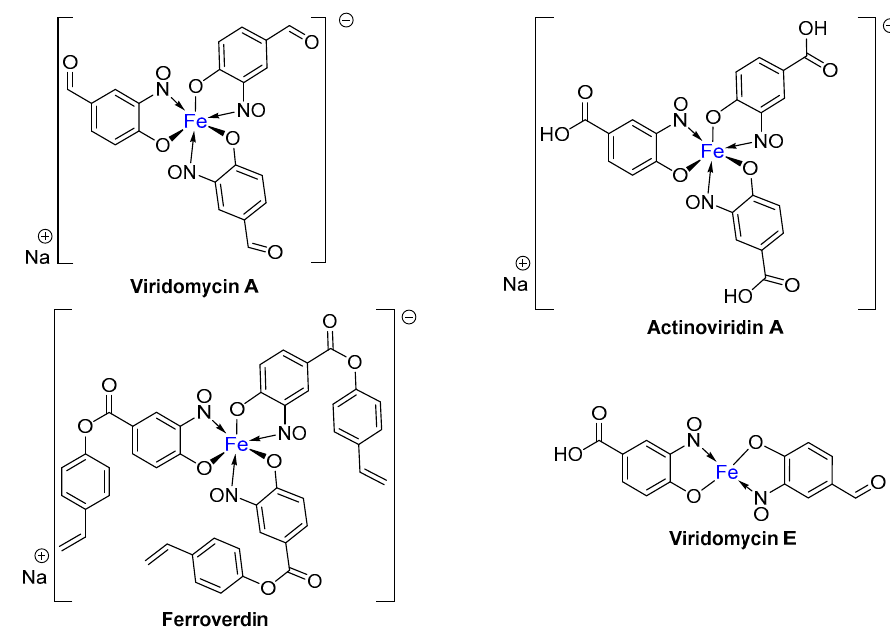
Figure 2. The structures of four antibiotics isolated from Stroptomyces bacteria, Viridomycin A